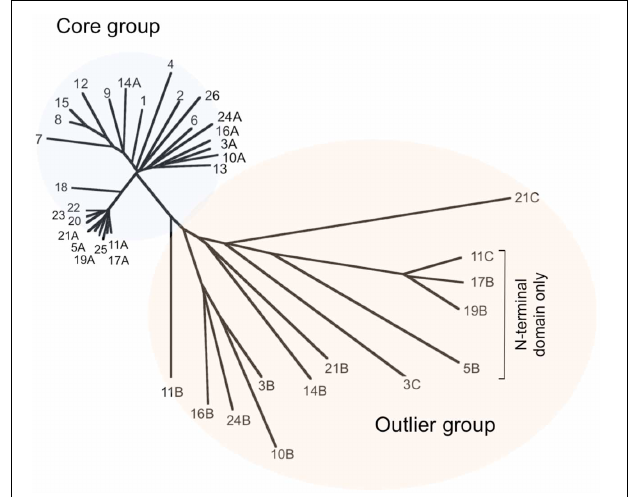
FIGURE 1 | Phylogenetic tree of representative haloarchaeal MCM proteins. The sequences of 39 proteins from 26 haloarchaeal genera were compared using ClustalX 2.1 (Larkin et al., 2007) and an unrooted phylogenetic tree generated using njplot (Perriere and Gouy, 1996). Twenty-six proteins (one from each included species) form a core group with the remaining 13 proteins designated as outliers. Individual proteins are numbered according to Table 1 . Accession numbers can also be found in Table 1 .